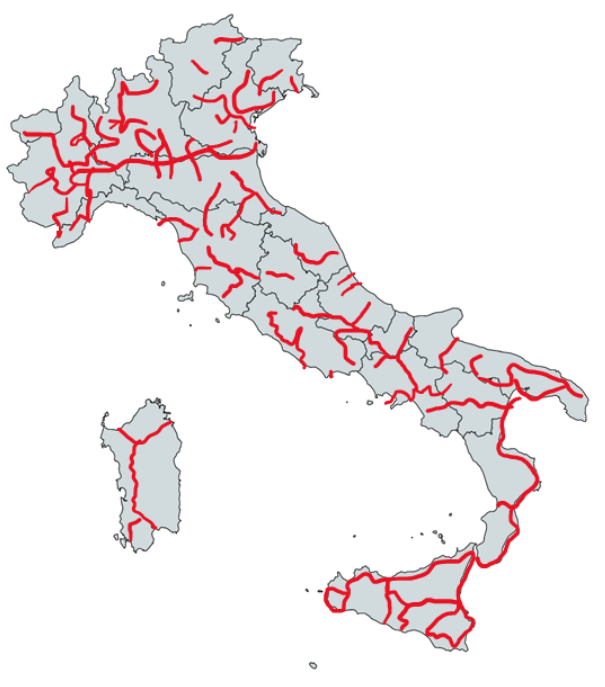
Figure 1. Italian railway lines on which the diagnostic vehicle under investigation operates (adapted from